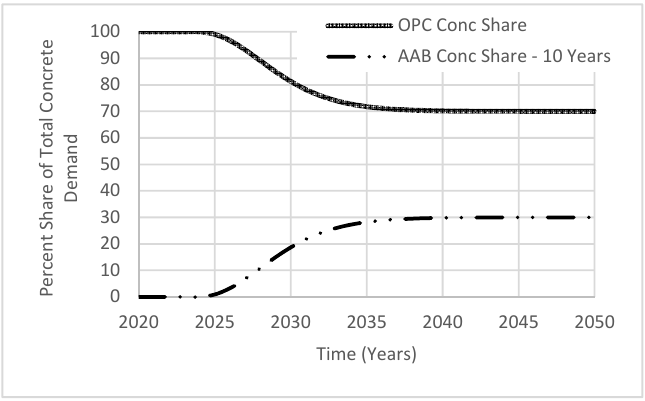
Figure 8. Total market share demand.